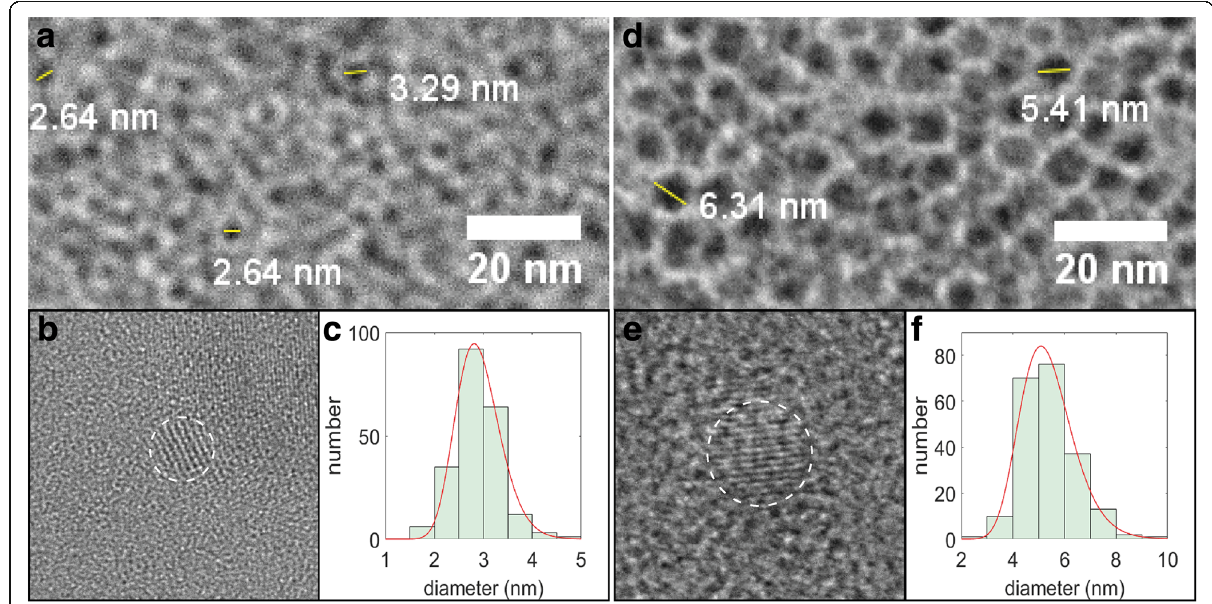
Fig. 2 TEM images of SiNCs. a Bright-field, b high resolution, and c size distribution histogram for the small SiNCs. Panels d – f represent a similar set of images from the large